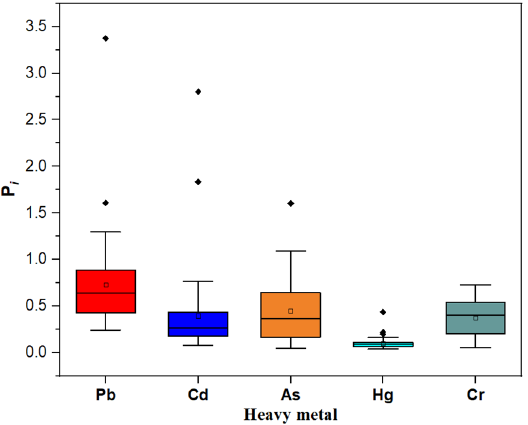
Figure 3. The single pollution index ( P i ) of five heavy metals in the subsurface soil of the study area. The Nemerow integrated pollution index ( P N ) analysis showed that the P N value of